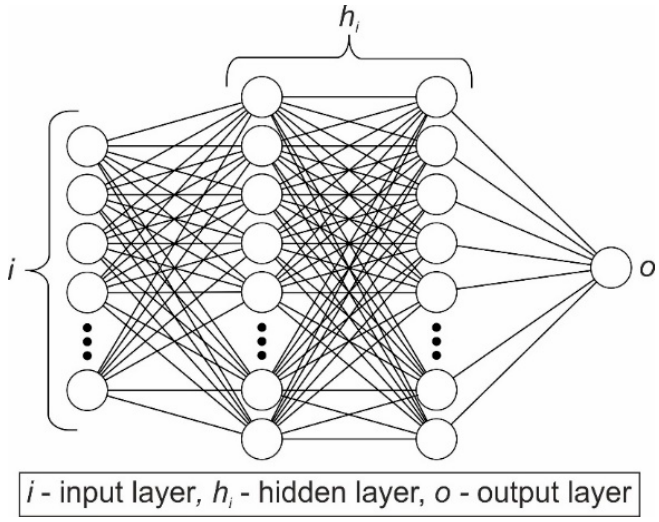
Figure 8. Diagram of the LSTM network.